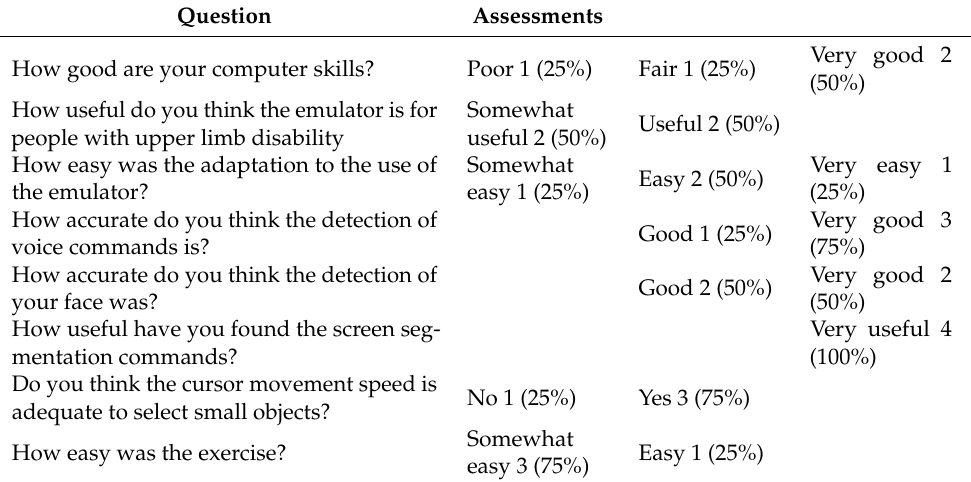
Table 6. Answer distribution in agreement with the four participants’ responses in Study